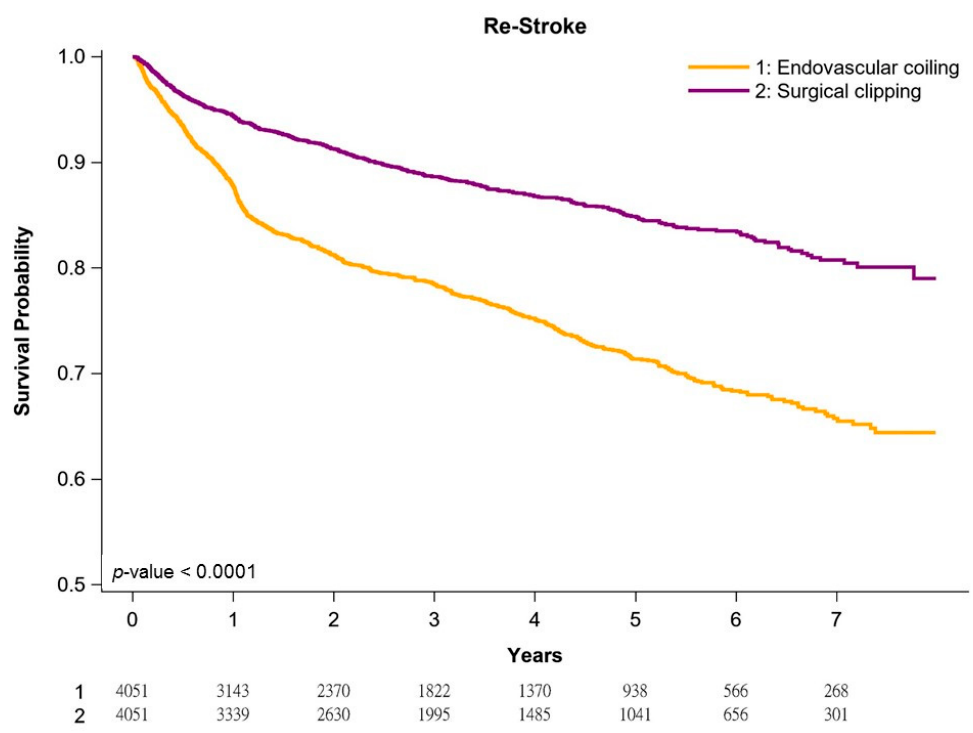
Figure 2. Kaplan–Meier vasospasm-free survival curves of propensity score-matched patients.